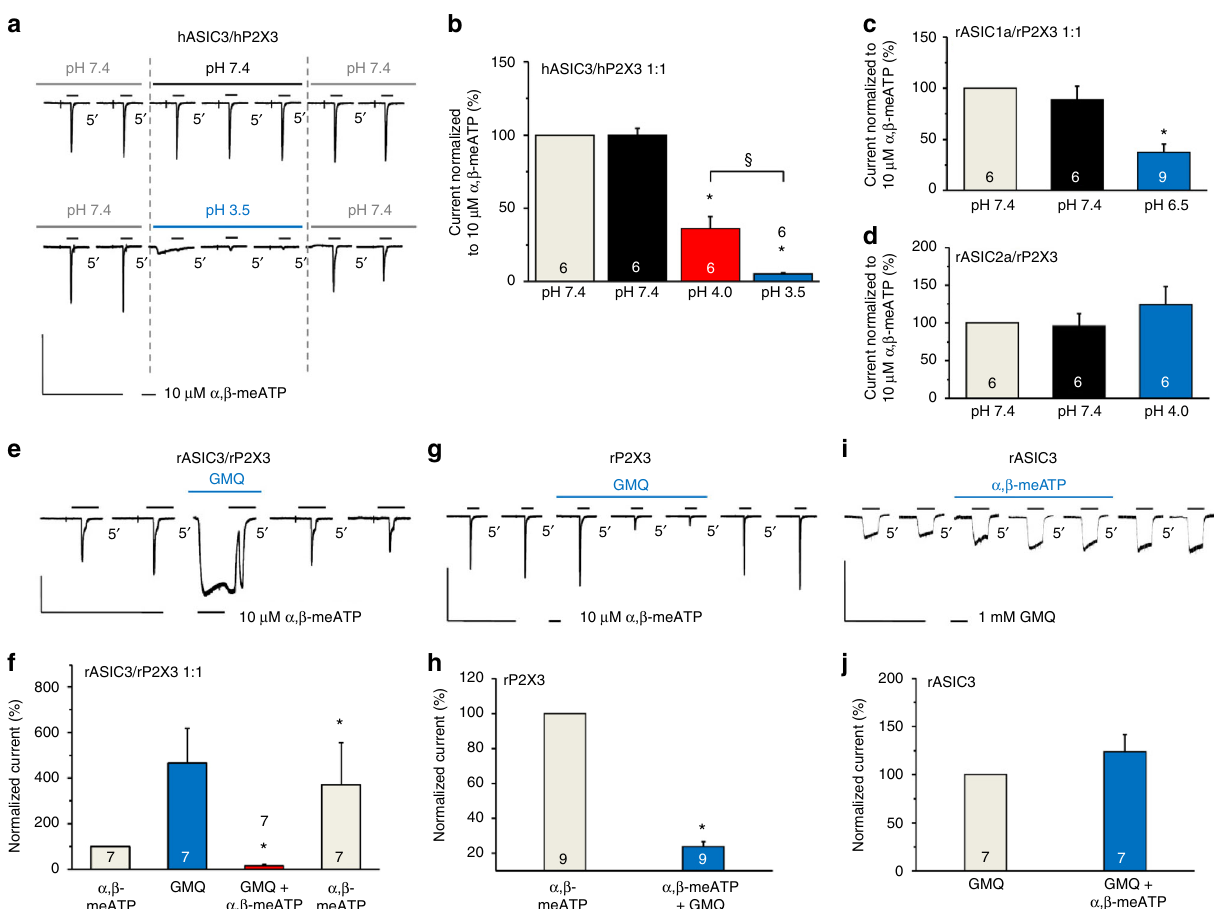
Fig. 3 Interaction between various ASICs and P2X3Rs after their transfection into CHO cells. CHO cells were transfected with various ASICs and P2X3Rs in a 1:1 ratio or transfected only with rP2X3R or rASIC3, as indicated. Whole-cell patch-clamp recordings at a holding potential of − 65 mV. a , b Interaction between hASIC3 and hP2X3Rs on their simultaneous activation. Interaction between rASIC1a ( c ) or rASIC2a ( d ) with rP2X3Rs on their simultaneous activation. The drug application and evaluation protocols were like those used in Fig. 2a – g. Means ± S.E.M. of the indicated number of experiments. * P < 0.05; statistically signi fi cant difference between the current amplitudes before and after the shift in pH. § P < 0.05; statistically signi fi cant difference between the pH-induced inhibition of the current amplitudes at pH 4.0 and 3.5 (one-way ANOVA followed by the Bonferroni test in both cases). e Current responses were elicited in CHO-rASIC3/rP2X3R cells by α , β -meATP (10 µ M) before, during and after the application of GMQ. f Means± S.E.M. percentage changes of the α , β -meATP-induced current responses were calculated with respect to the second current amplitude before GMQ application. g Inhibition of current responses to α , β -meATP in CHO-rP2X3R cells. h Means ± S.E.M. percentage inhibition in the indicated number of experiments as shown in ( g ). i No change of the GMQ (1 mM)-induced current in the presence of α , β -meATP (10 µ M) in CHO-rASIC3 cells. j Means ± S.E.M. percentage change in the indicated number of experiments as shown in ( i ). * P < 0.05; statistically signi fi cant difference from the α , β -meATP-induced current amplitudes before GMQ application (one-way ANOVA followed by the Bonferroni or Mann – Whitney test, as appropriate). The scale labels for the vertical bars were 2 nA ( a , g , i ) and 1 nA ( e ). The scale labels for the horizontal bars were 50 s ( a , e , g , i